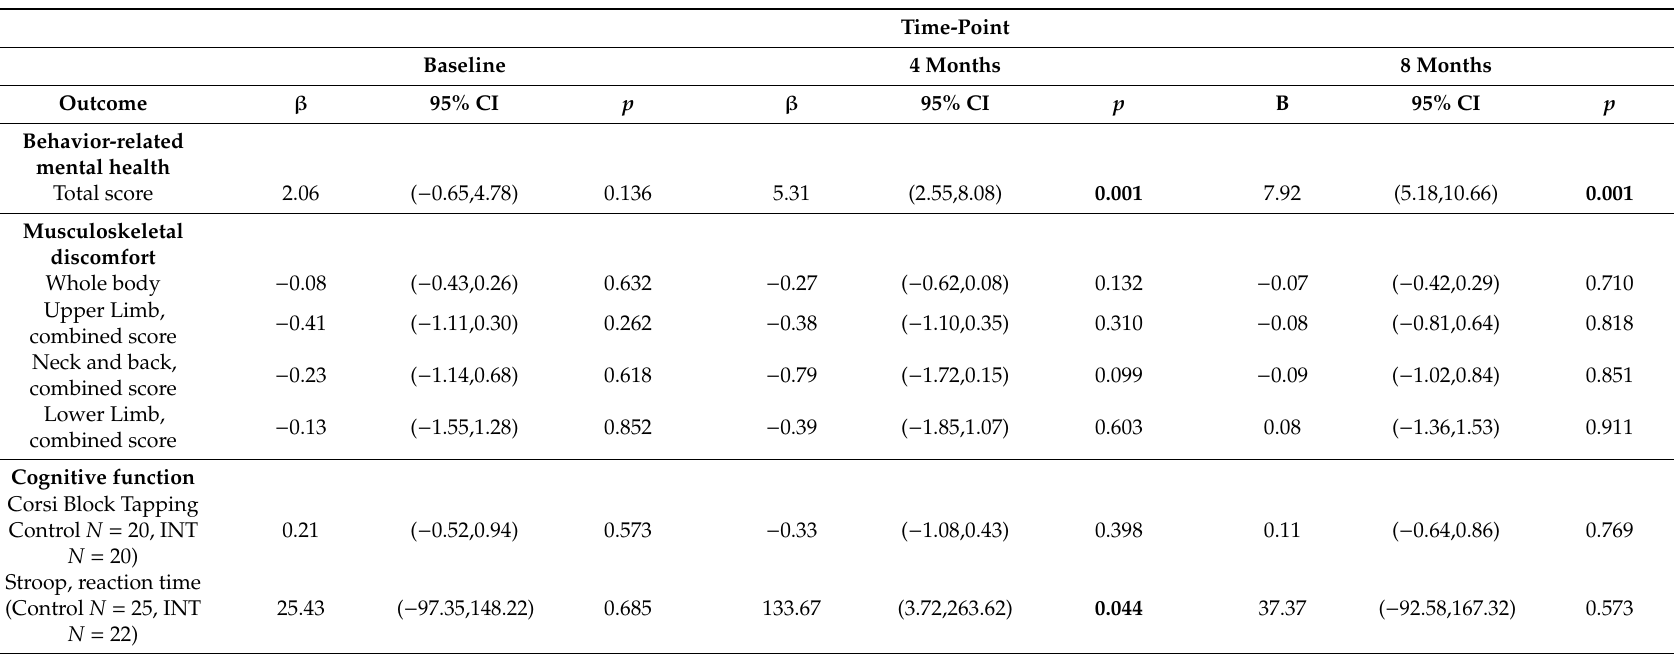
Table 4. Estimated e ff ect sizes of the intervention in behavior-related mental health, musculoskeletal discomfort, and cognitive function at baseline, 4 months, and 8 months from multi-level models. Control n = 27, Intervention n =